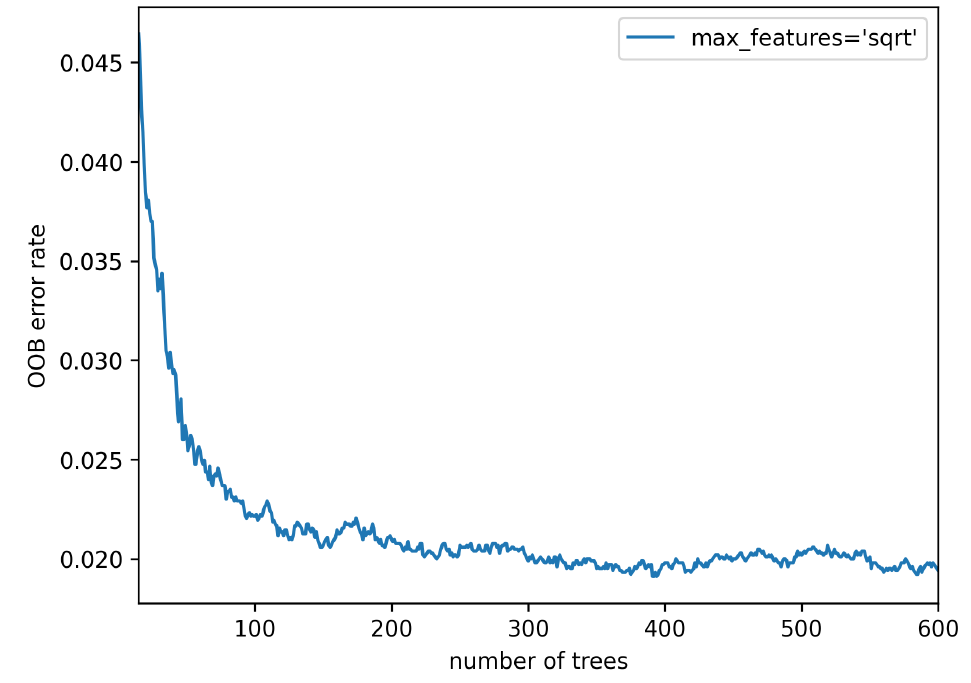
Figure 8. OOB error rate versus the number of